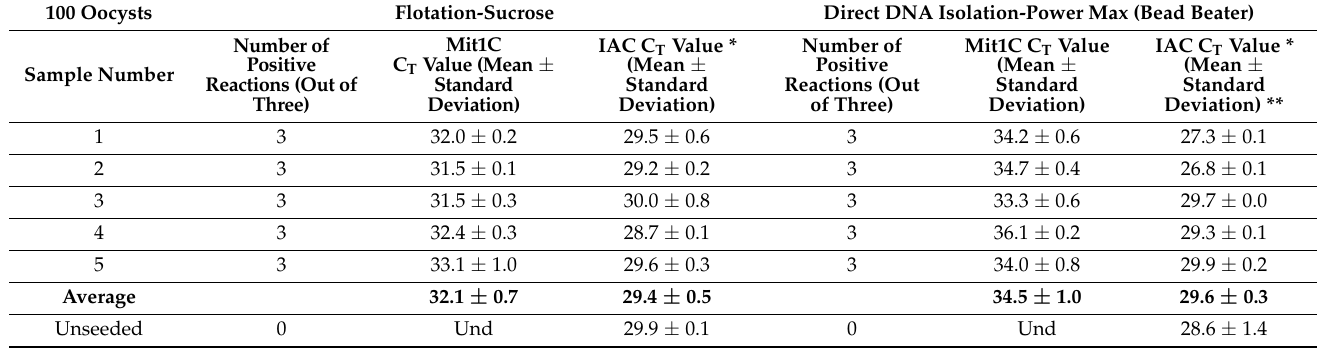
Table 4. qPCR Mit1C detection data (number of positive qPCR replicates, individual C T values for C. cayetanensis and IAC for each sample) in samples of soil (10 g) seeded with 100 C. cayetanensis oocysts using different DNA isolation methods and molecular